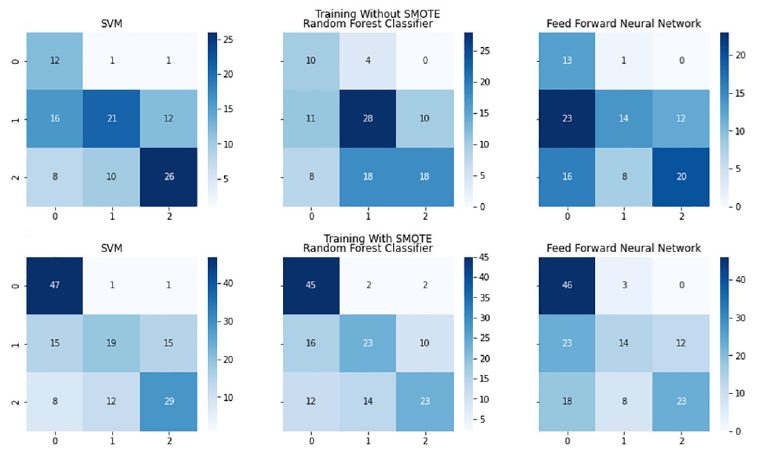
Fig 6. Confusion matrices of machine learning models trained on data oversampled by SMOTE and data trained with class weights given to the loss function. Because the naive class is oversampled using SMOTE, new data points are generated by interpolating between existing observations. As reflected in the confusion matrices, such an action results in ML models overfitting to the oversampled class, exhibiting an inflated accuracy on that class. The present oversampling approach has only a little effect on the performance on other two